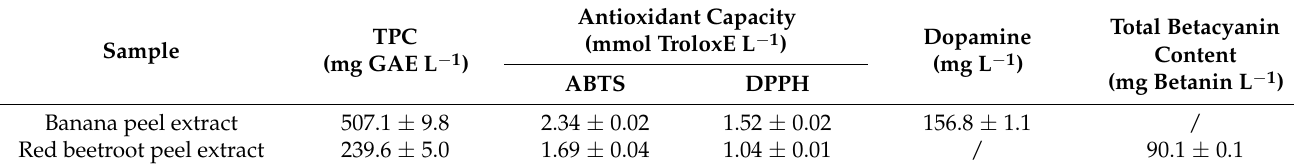
Table 2. Bioactive characterization of banana and red beetroot peel